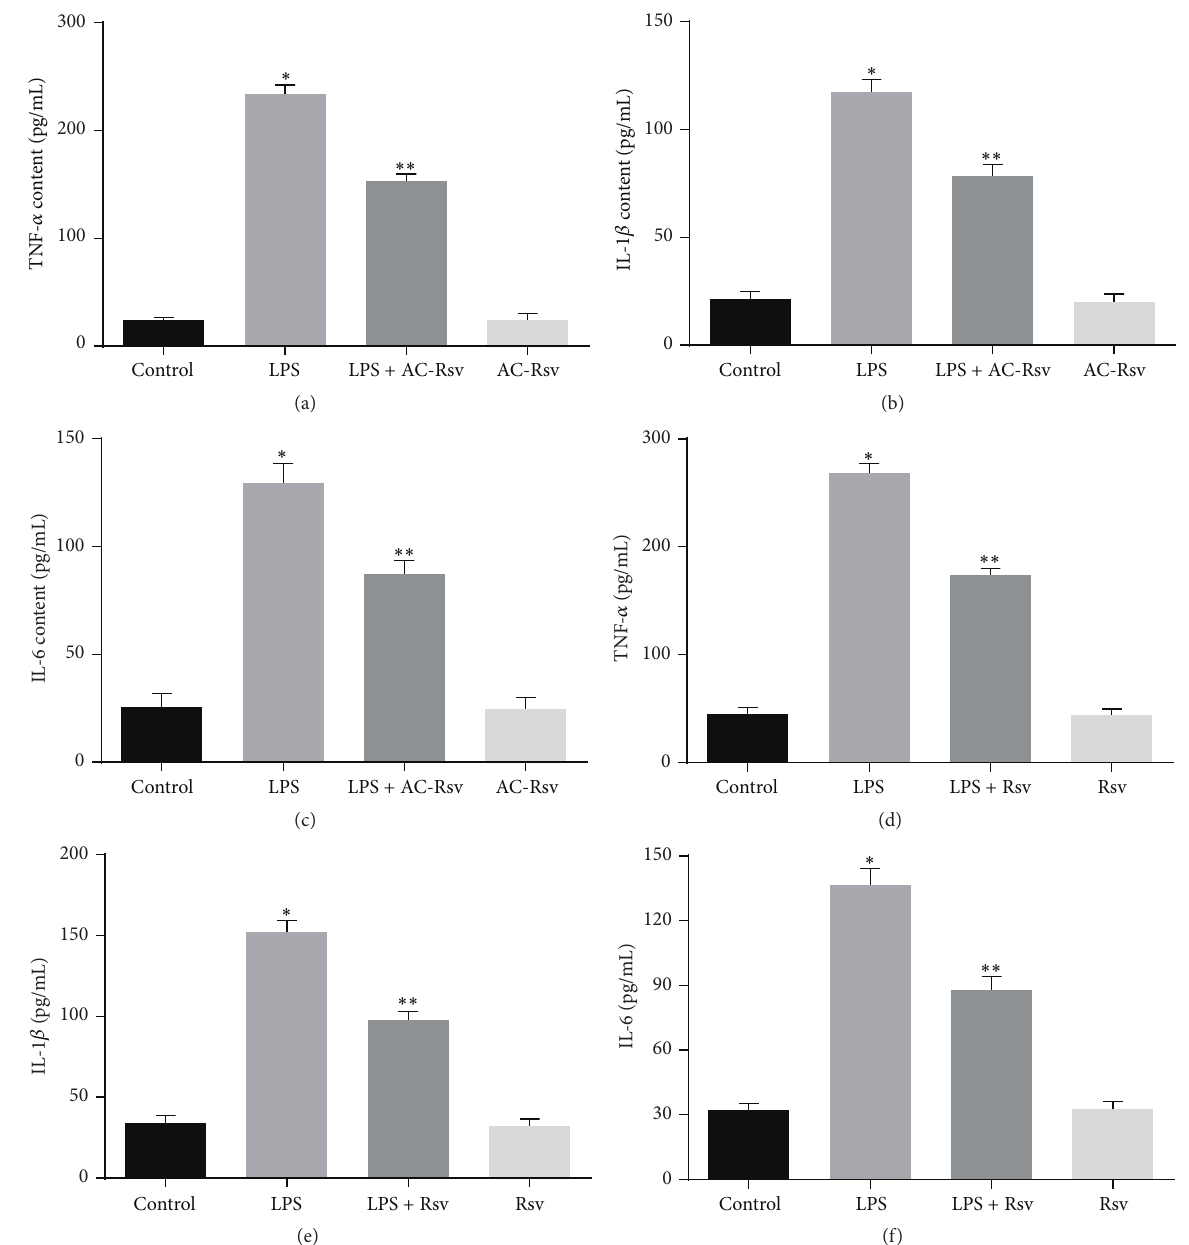
Figure 5: Effects of AC-Rsv on content of cytokines in LPS stimulated lungs and NR8383 cells have been measured by ELISA. (a–c) TNF- 𝛼 , IL-6, and IL-1 𝛽 levels in lungs, (d–f) TNF- 𝛼 , IL-6, and IL-1 𝛽 levels in NR8383 cells. Data are expressed as mean ± S.D. 𝑛 = 8 . LPS stimulation increased the content of TNF- 𝛼 , IL-6, and IL-1 𝛽 in lungs and NR8383 cells compared with that of control, ∗ 𝑃 < 0.05 versus control, while AC-Rsv and Rsv treatment significantly inhibited the formation of those cytokines in lung and NR8383 cells, respectively. ∗∗ 𝑃 < 0.05 versus ∗ 𝑃